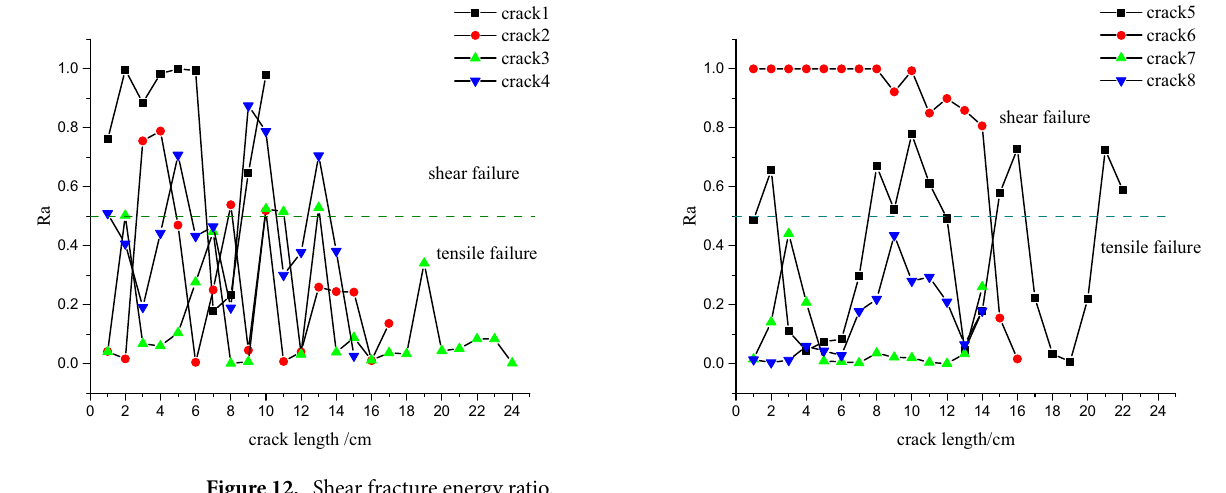
Figure 12. Shear fracture energy